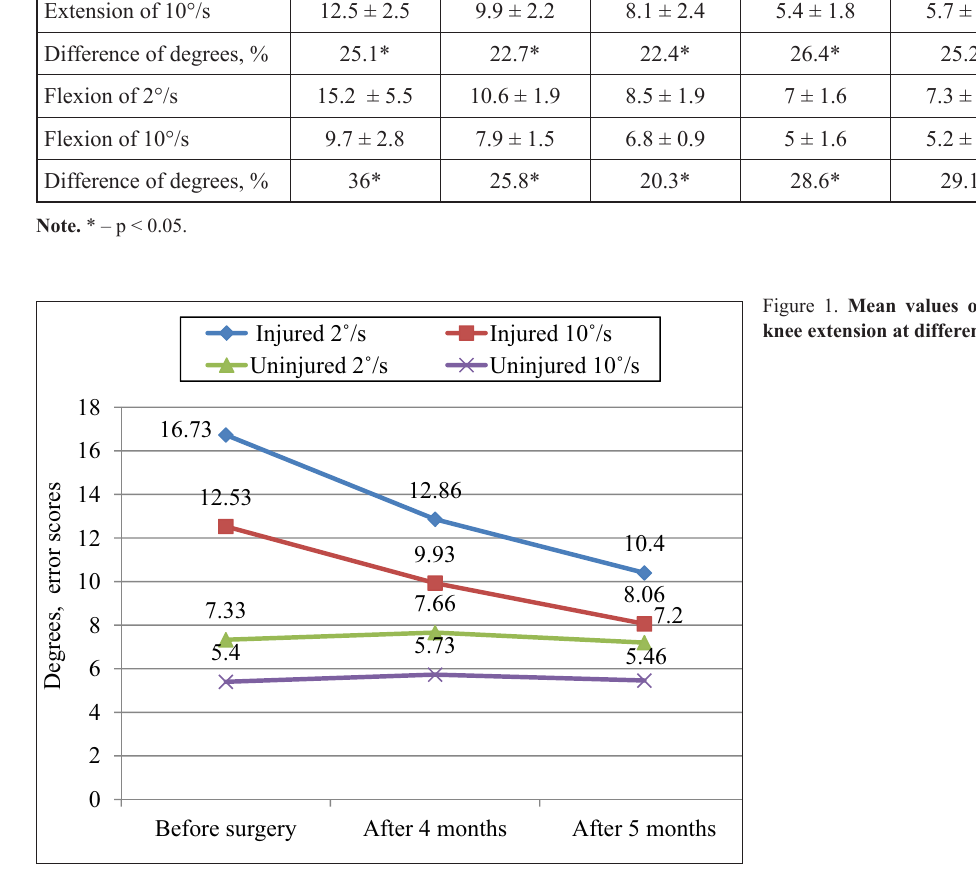
Figure 1. Mean values of uninjured and injured knee extension at different velocities (p < 0.05)